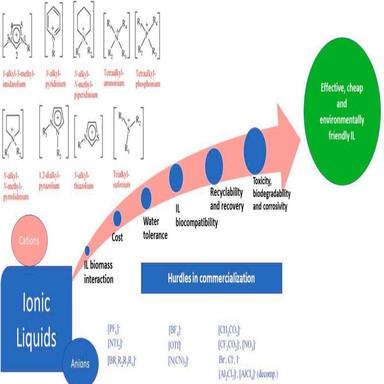
Some challenges to overcome scale up production.